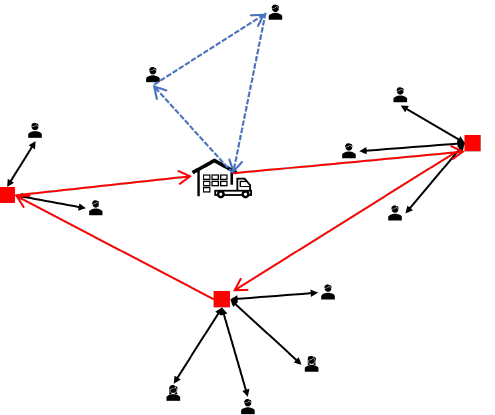
Figure 3. Example derived from Instance 7 from Table 4 without service cost of the customers.